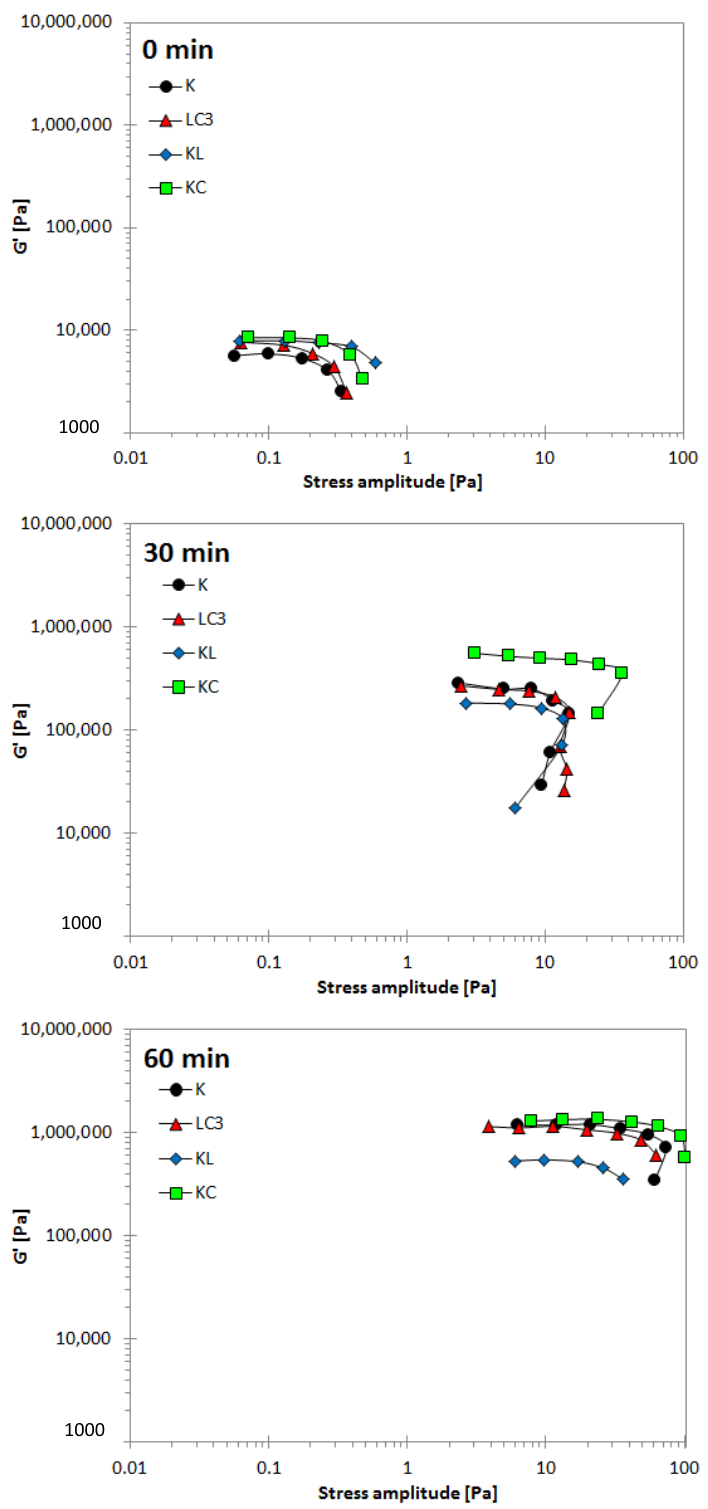
Figure 6. Elastic modulus vs. stress amplitude needed to yield the binders at different resting